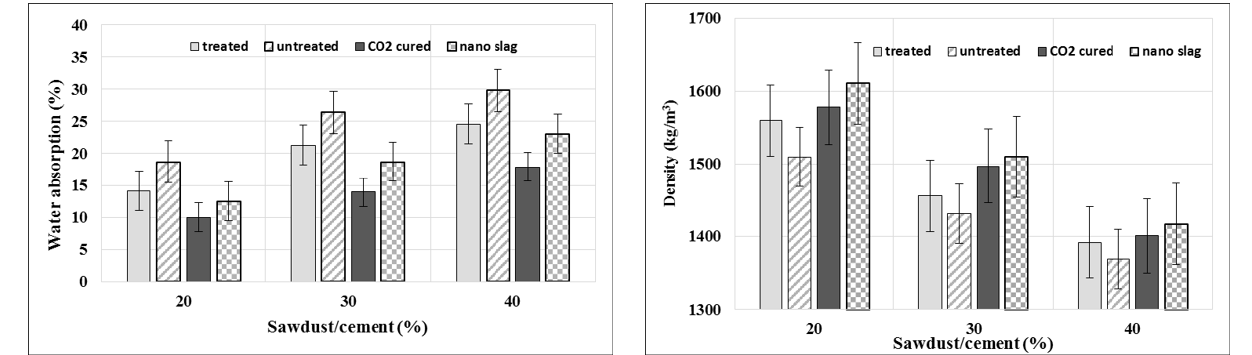
Figure 5: Density of cement-bonded particleboard prior to and after different accelerated effects.